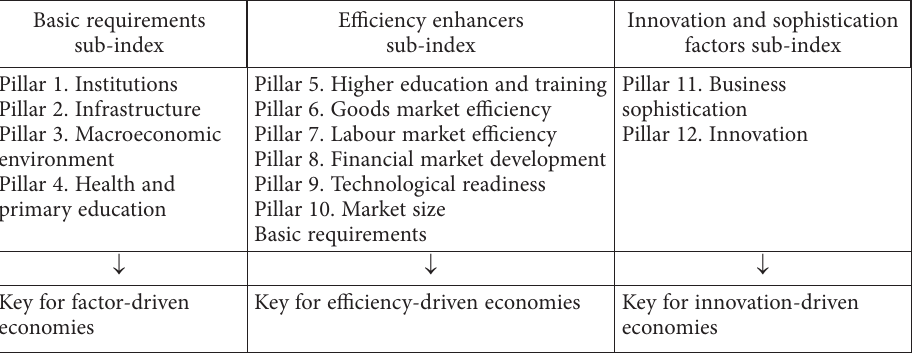
Table 1. The Global Competitiveness Index framework (according to the Global Competitiveness Re- port) (source: WEF, 2017)